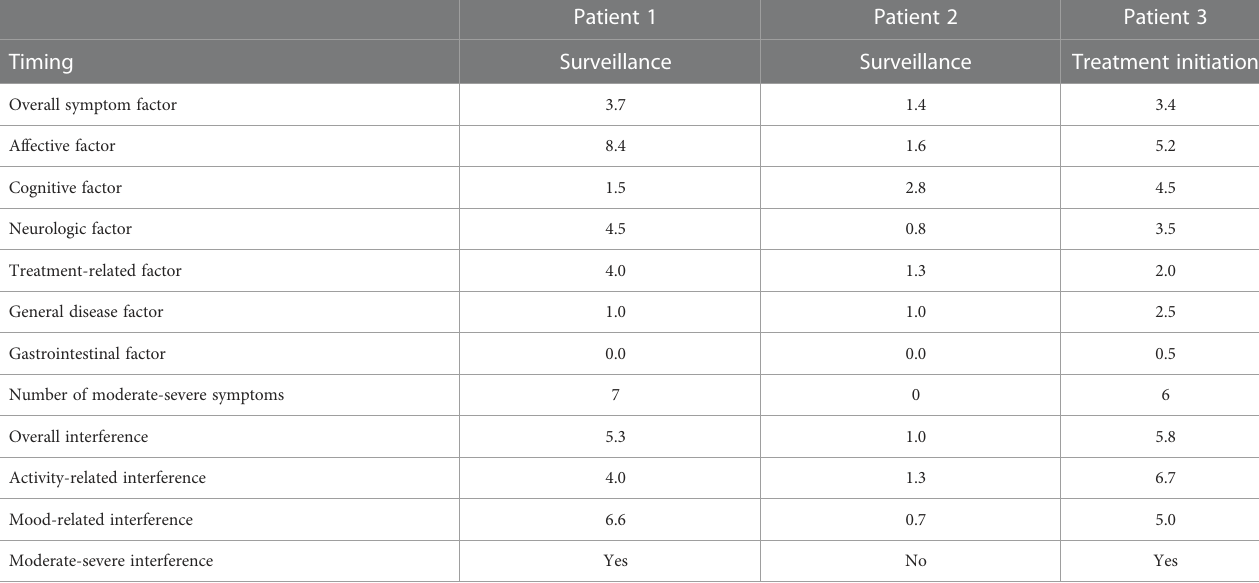
TABLE 1 MDASI-BT measurement of symptom burden and interference for Patients 1 –